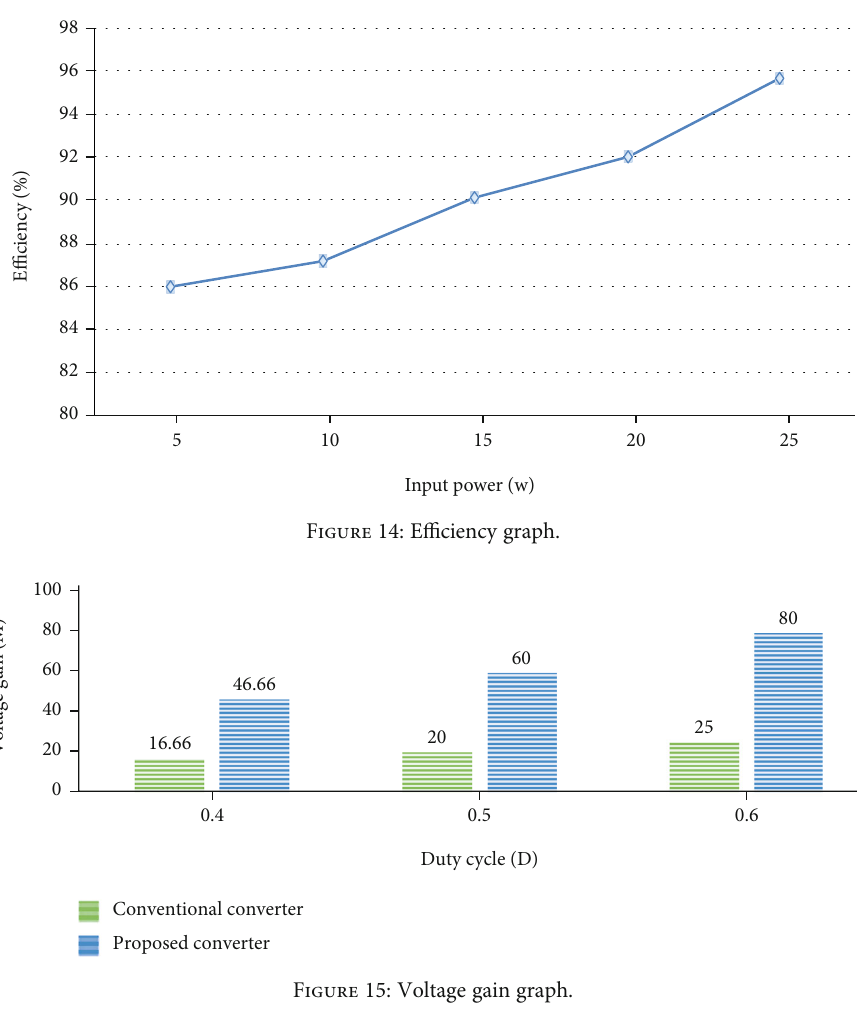
Figure 15: Voltage gain graph.